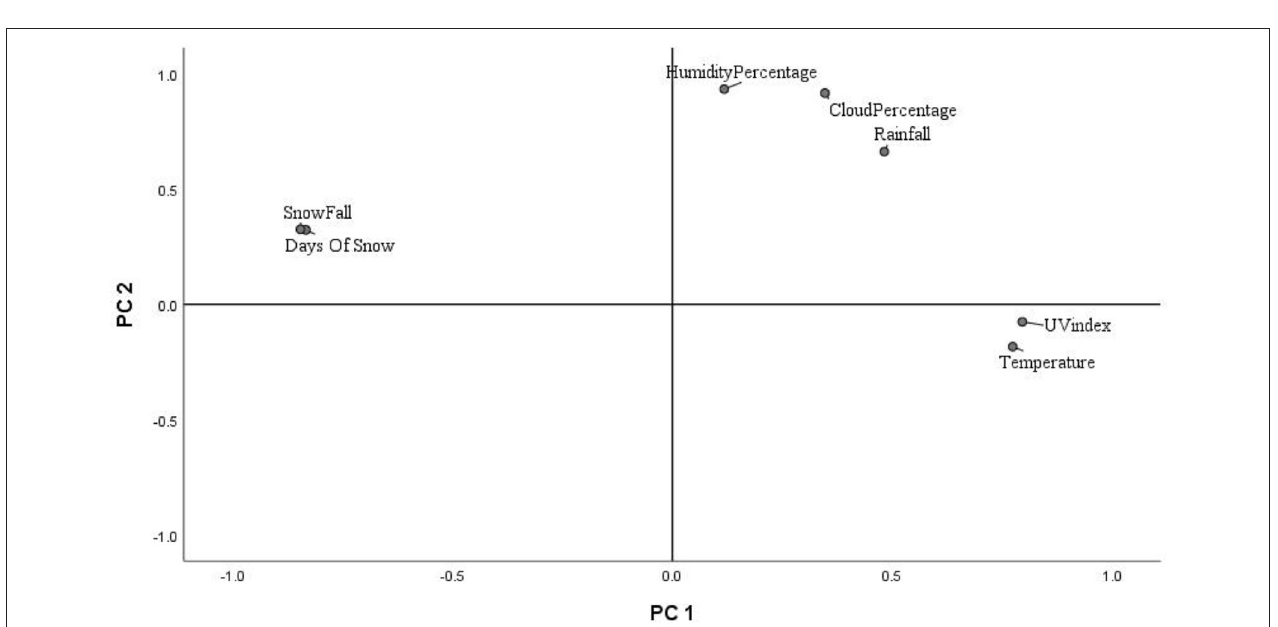
FIGURE 3 | PCA biplot of weather conditions correlation during the 720-day